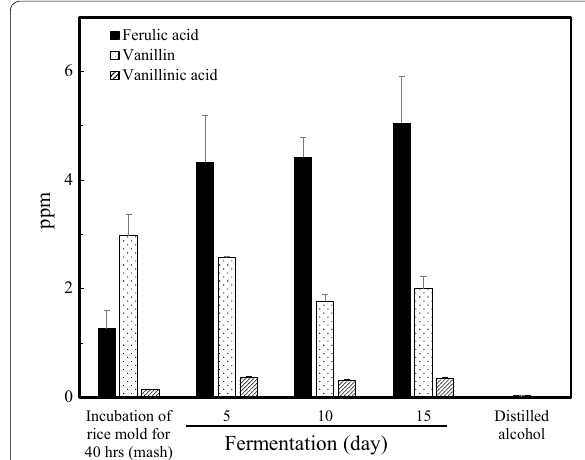
Fig. 4 Phenolic compounds of biotransformation in Aspergillus luchuensis during